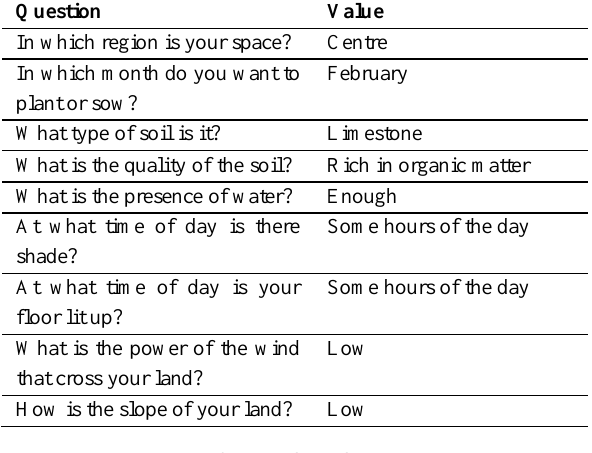
Table 10. Results of the ES in Scenario 1